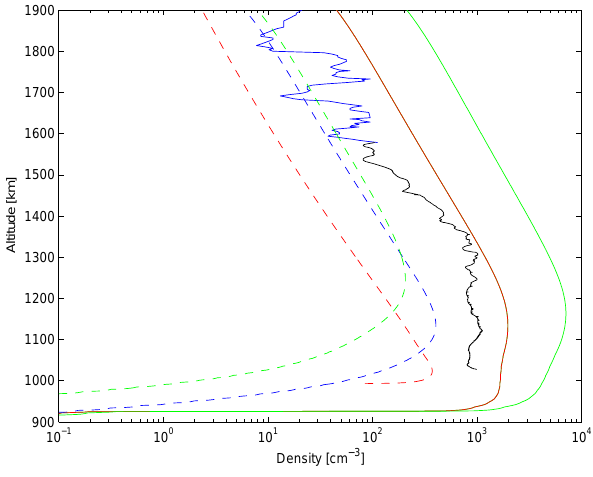
Fig. 12. Densities of the ion species and the total electron density for energies ranging from 10 eV to 1000 eV with incident fluxes reduced by afactor of ten.